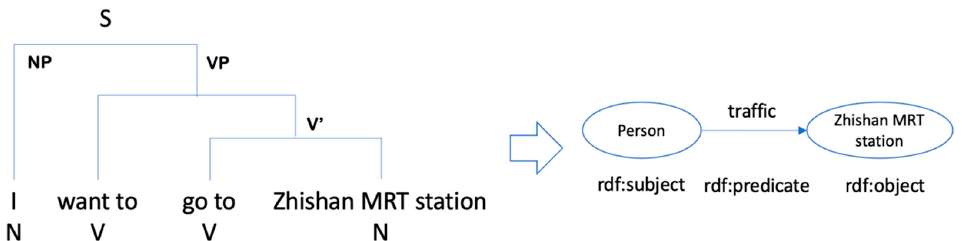
Figure 4. Dependency trees to RDF triple maps.